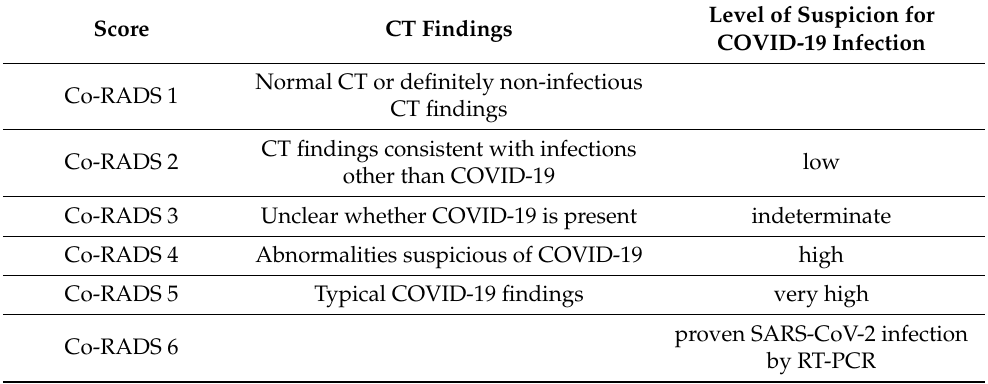
Table 1. Co-RADS criteria